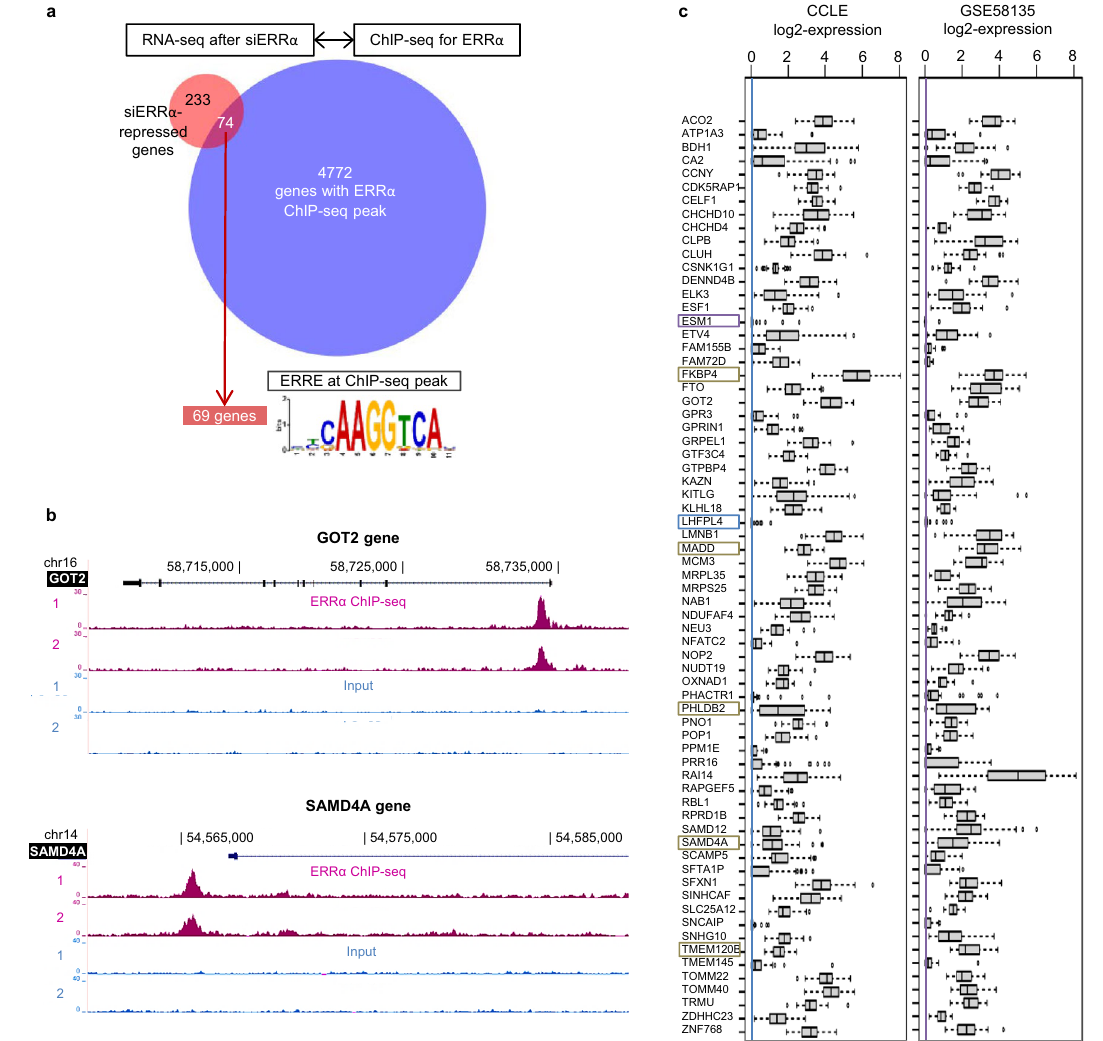
Figure 1. Direct ERRα-activated genes in MDA-MB-231 cells. ( a ) Venn diagram showing the amount of genes displaying reduced expression upon siERRα treatment and associated with a ChIP-seq peak for ERRα. The ERR response element (ERRE, JASPAR motif MA0592.3) was detected at ChIP-seq peak (± 250 bp around peak) by the FIMO tool of the MEME-Suite for 93% of the identified ERRα-activated genes, which were taken as direct ERRα-activated targets. ( b) Graphs obtained from the UCSC browser showing the two replicates of ERRα ChIP- seq and input signals for two genes displayed as examples. ( c) Expression of the 69 identified ERRα-activated genes in the BC cells of CCLE and GSE58135 datasets. Expression is log2 of upper-quartile normalized TPM (for CCLE) or FPKM (for GSE58135) values. In each dataset, genes are ordered according to decreasing mean expression value. Color rectangles indicate removed genes due to low expression (colored line) or not expressed in at least one cell line of the